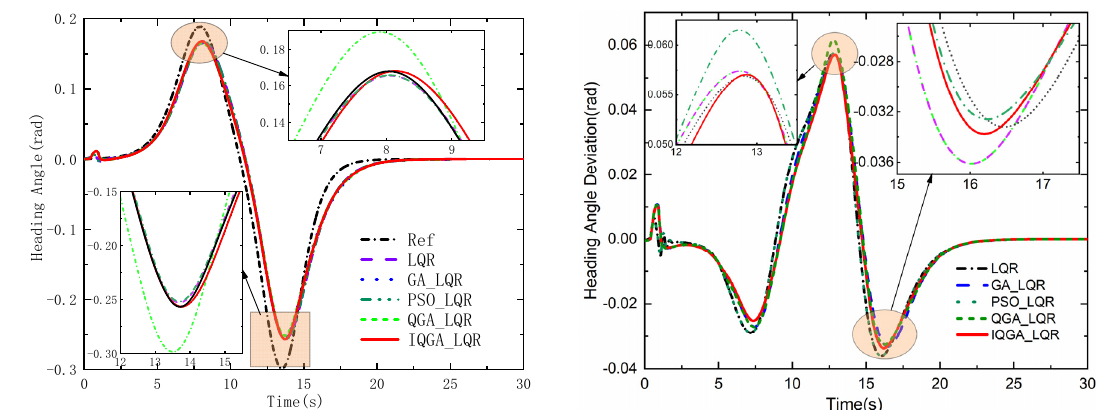
Figure 13. Longitudinal displacement and deviation.